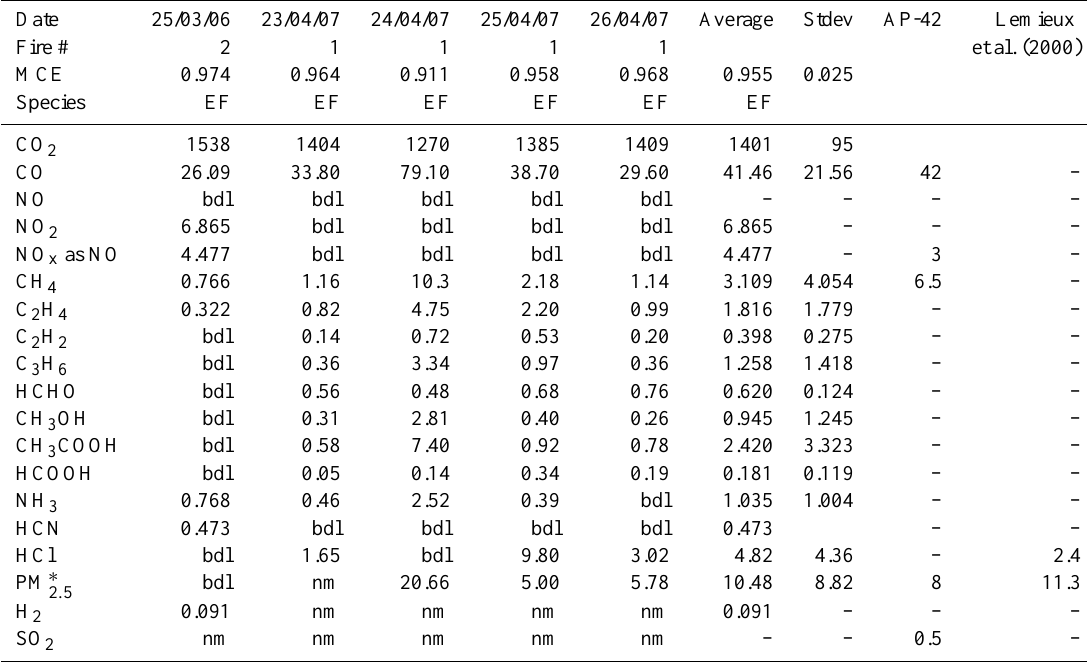
Table 7. Emission factors (EF, gkg − 1 ) and modified combustion efficiency (MCE) measured for open burning of garbage in Mexico compared to other work.